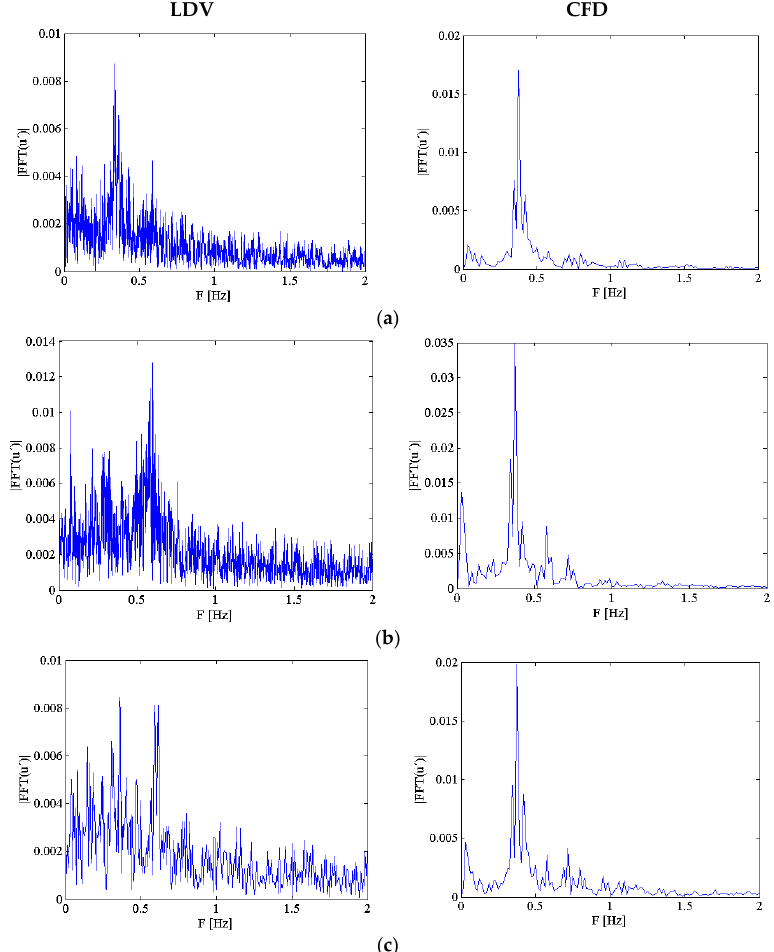
Figure 9. Single-sided FFT amplitude spectrum of the streamwise velocity fluctuations for LDV and CFD at ( a ) the large cylinder, x / D = 2.5, z / D = − 0.5, y / D = 0.75 ( b ) small cylinder, x / d = 2.5, z / D = 0.5, y / d = 0.75; and ( c ) diameter step, x / D = 2.5, z / D = 0.0, y / D = 0.75.